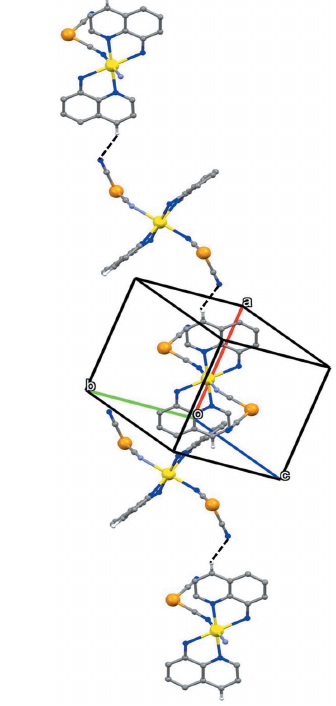
Figure 3 Part of the crystal structure showing the formation of a hydrogen-bonded chain running parallel to the [201] direction. For the sake of clarity, the H atoms not involved in the motif shown have been omitted.